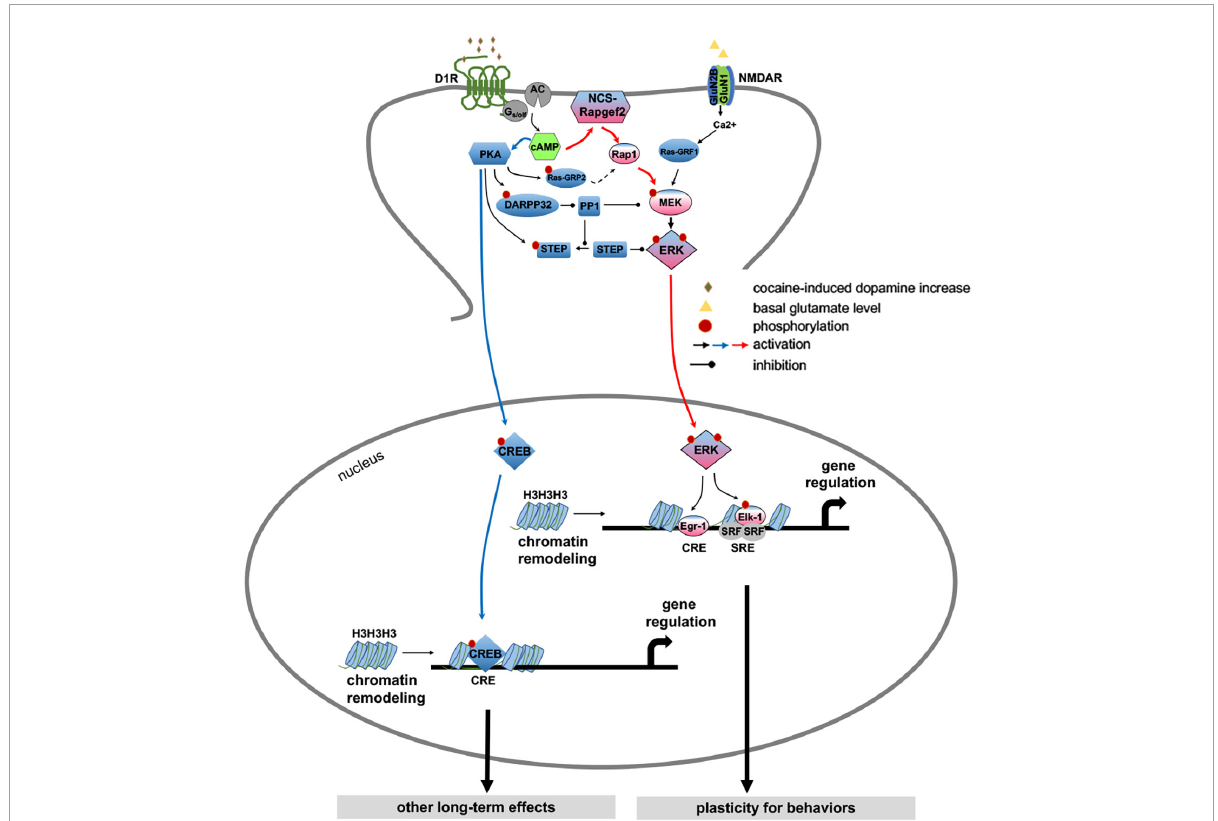
FIGURE6 Proposed model for direct dopamine-dependent ERK1/2 activation in dSPNs (Jiang et al., 2021). Cocaine acts by increasing synaptic dopamine leading to ERK activation in NAc, required for locomotor sensitization and CPP. It has previously been proposed that D1 receptor activation affects ERK activity only indirectly, via PKA- and DARPP-32/STEP-mediated inhibition of ERK dephosphorylation (Svenningsson et al., 2004; Valjent et al., 2005), whereas direct ERK activation itself occurs in the D1 MSNs only via NMDAR-dependent glutamatergic signaling (Pascoli et al., 2011; Cahill et al., 2014) through calcium-sensitive Ras-guanine nucleotide releasing factor (Ras-GRF1) (Farnsworth et al., 1995; Fasano et al., 2009). We propose here a more parsimonious mechanism for ERK-dependent cocaine-induced dopaminergic signaling, in which cAMP elevation by dopamine in D1-MSNs results in parcelation of signaling between ERK and CREB with separate cellular consequences under the control of each pathway. An indirect modulatory role for PKA-dependent ERK phosphatase inhibition after psychomotor stimulant administration (Valjent et al., 2005; Sun et al., 2007), and additional ERK regulation by glutamatergic input to D1 dopaminoceptive neurons in the context of cellular plasticity underlying cocaine addiction (Valjent et al., 2000; Park et al., 2013; Cahill et al., 2014; Pascoli et al., 2014) is not contradicted by this model. We posit that D1 receptor activation, and cAMP elevation, in D1 MSNs likely results in parallel effects on ERK, both directly via NCS-Rapgef2 and indirectly via PKA with the effects of cocaine requiring multiple necessary, but perhaps individually insufficient inputs activated by dopamine, that converge on D1-MSN ERK phosphorylation. These include PKA/DARPP/STEP/PP1 (Svenningsson et al., 2004), PKA/RasGRP2/Rap1 (Nagai et al., 2016a,b), a NMDAR-dependent Ras activation (Fasano et al., 2009; Pascoli et al., 2011), and